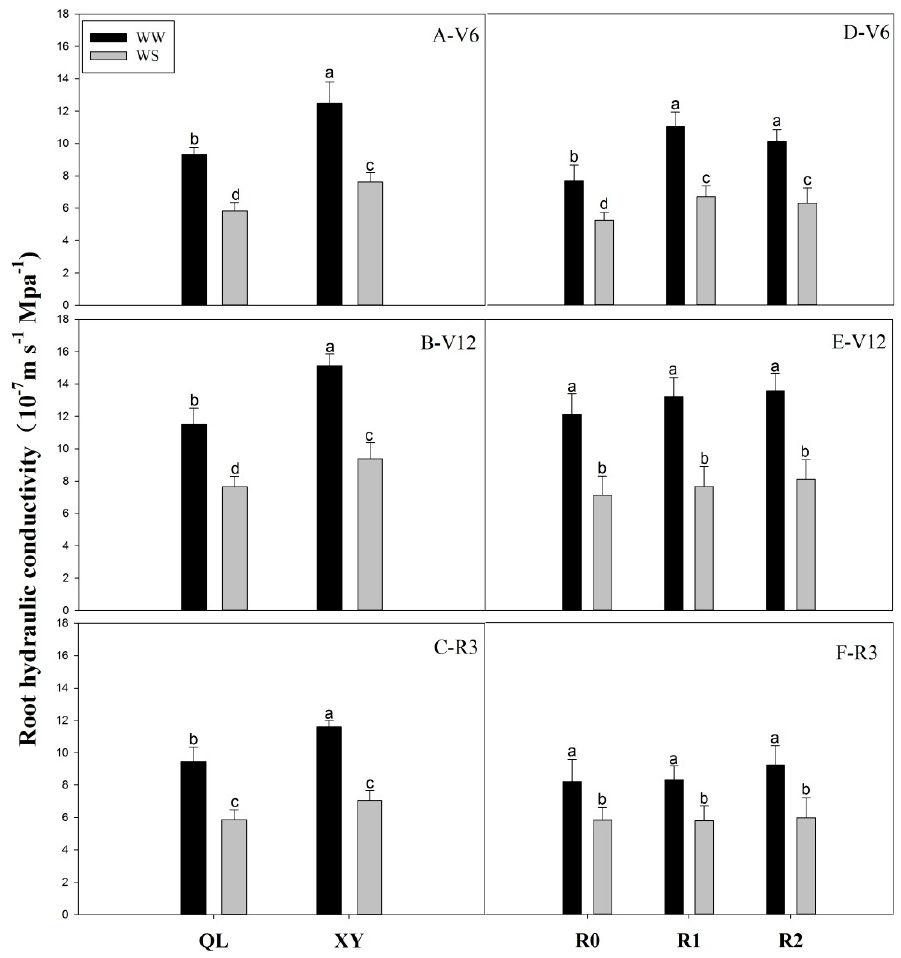
Figure 2. Lpr in Experiment 1 at jointing stage ( A − V6), anthesis stage ( B − V12), and milk stage ( C − R3); Lpr in Experiment 2 at jointing stage ( D − V6), anthesis stage ( E -V12), and the milk stage ( F − R3). Values are means ± standard error ( n = 6). Different letter indicates significant differences among treatments ( p < 0.05) based on Duncan’s test. The treatment abbreviations are defined in Figure 1.